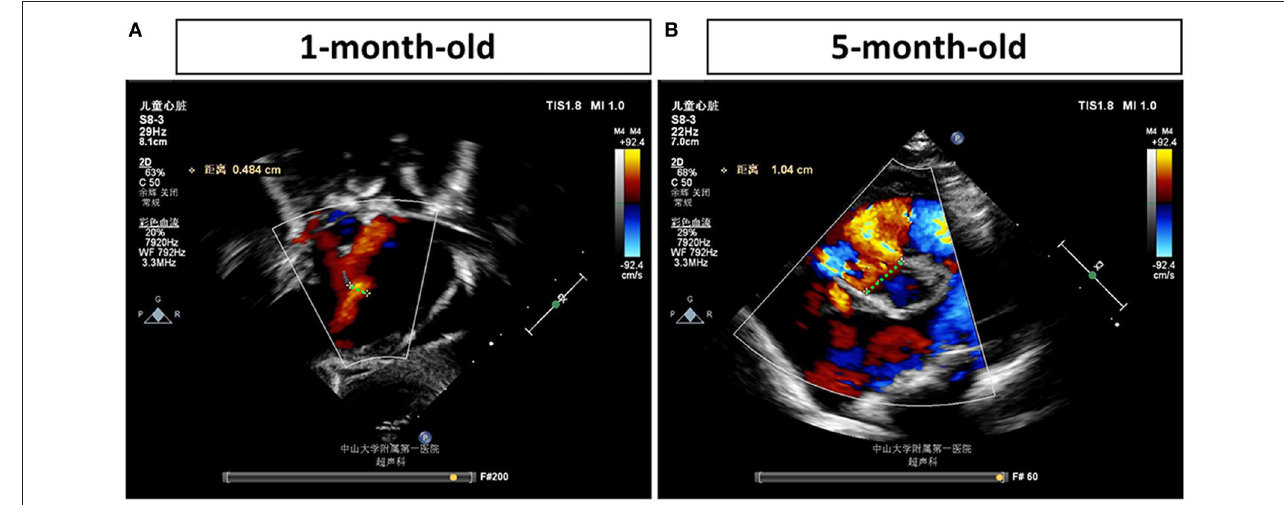
FIGURE 1 | Echocardiogram examinations of the proband at different time points. Representative image of the echocardiogram of the proband’s left ventricle obtained in the parasternal long-axis view (A) shows a ventricular septal defect (VSD) (0.484cm) at 1 month of age. Representative image of the echocardiogram (B) shows a more severe VSD, which is enlarged to 1.04cm, in the proband’s heart at 5 months of age. The largest distances of VSD are marked by green dash lines and measured.